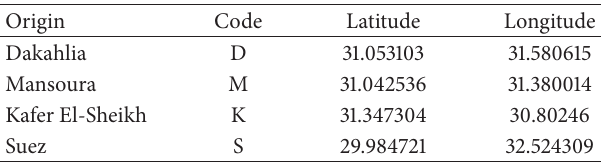
Table 1: Geographic locations of okra samples used for determina- tion of vitamin